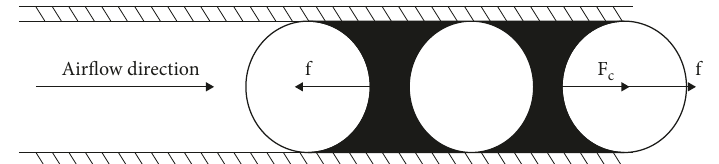
Figure 1: Schematic diagram of proppant